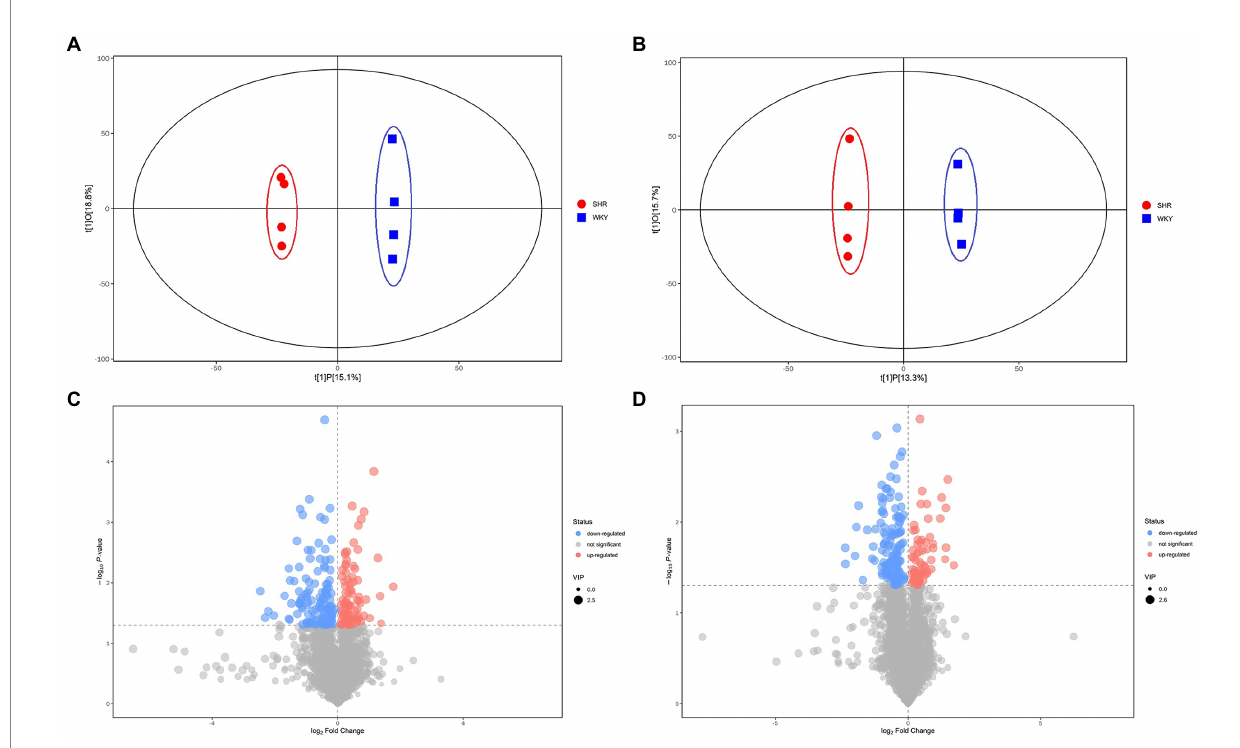
FIGURE 2 (A) Score scatter plot of the OPLS-DA model for the positive ion mode. (B) Score scatter plot of the OPLS-DA model for the negative ion mode. (C) Volcano plot for the positive ion mode. (D) Volcano plot for the negative ion